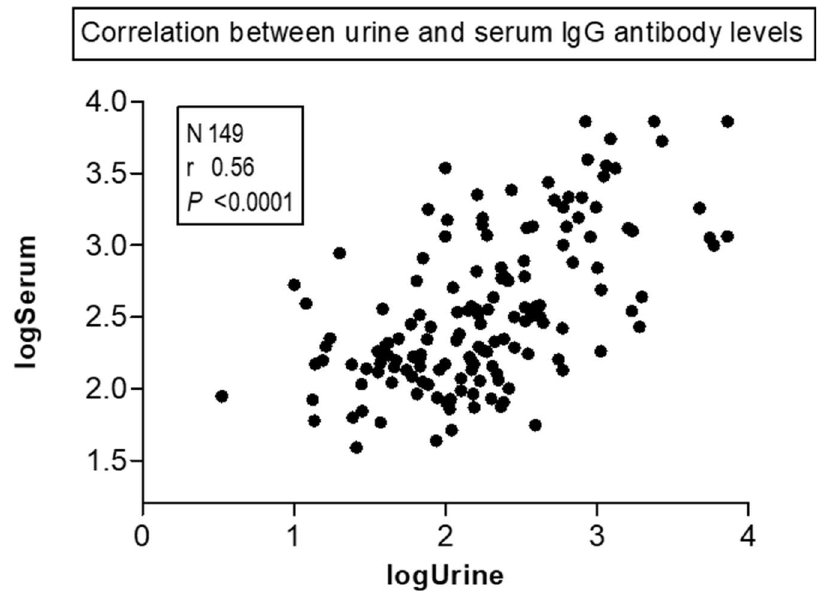
Fig 5. Correlation between urine IgG and serum IgG antibodies. Log-transformed variables. Correlation coefficient determined by Pearson product-moment correlation test.